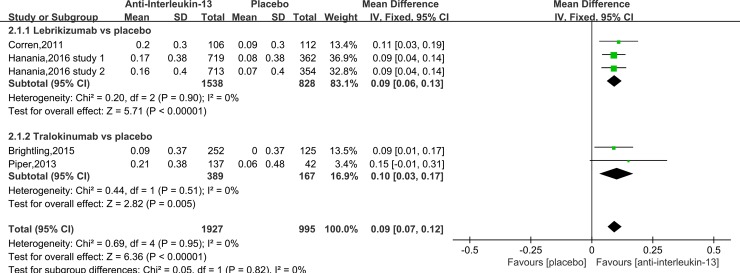
Forest plot comparing anti-IL-13 and placebo with FEV1.